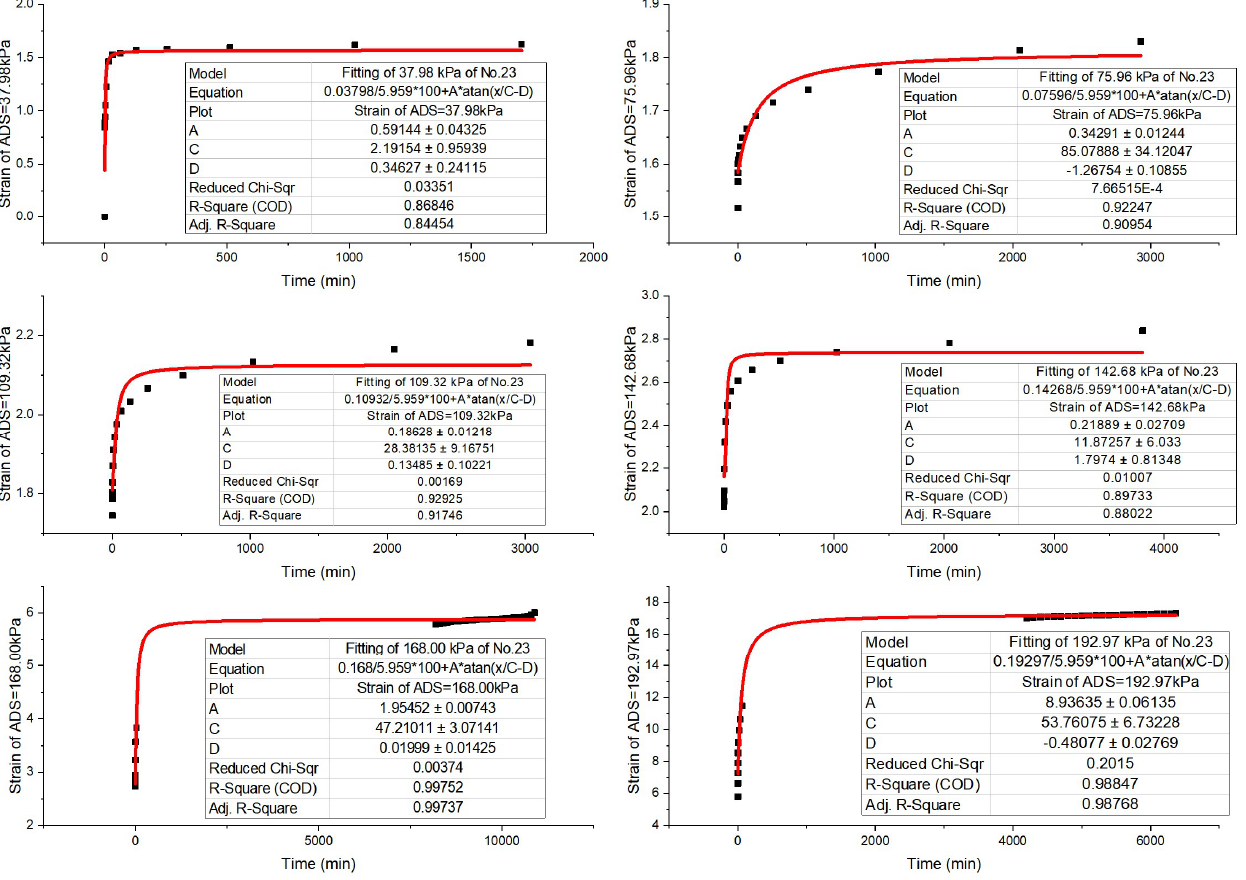
Figure 32. The fitting image of strain(%)–time(min) of Specimen 23.